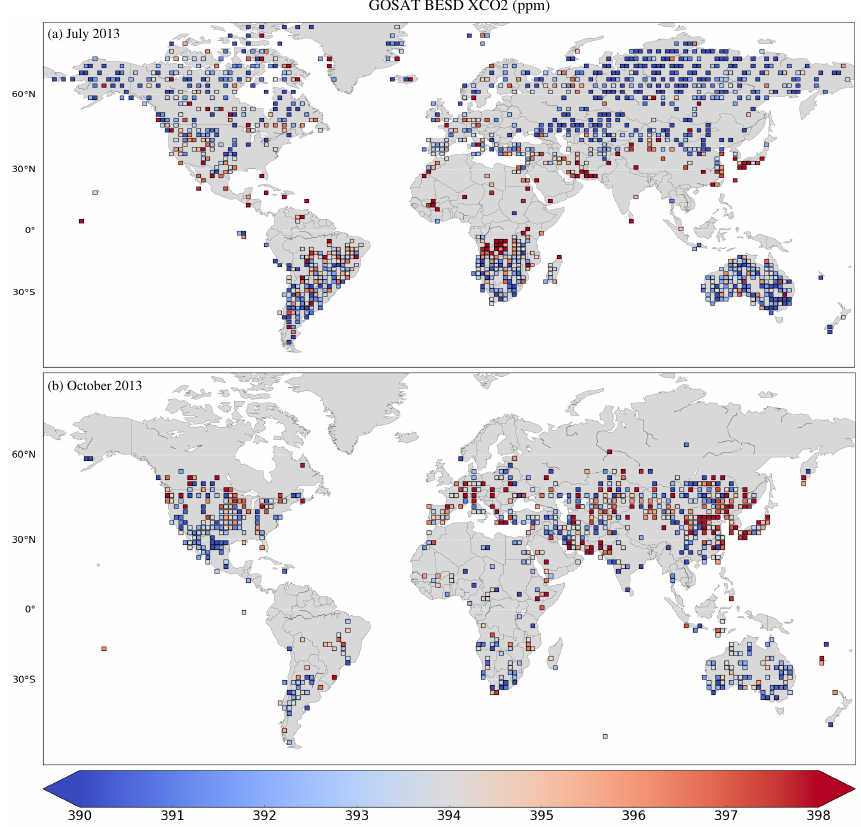
Figure 1. Example of the distribution of the assimilated GOSAT BESD XCO 2 data: July 2013 (top panel, about 3400 retrievals) and October 2013 (bottom, about 1270 retrievals). The monthly data are here aggregated on a 2 ◦ × 2 ◦ grid and averaged. The blue/red represents the low/high averaged XCO 2 values in